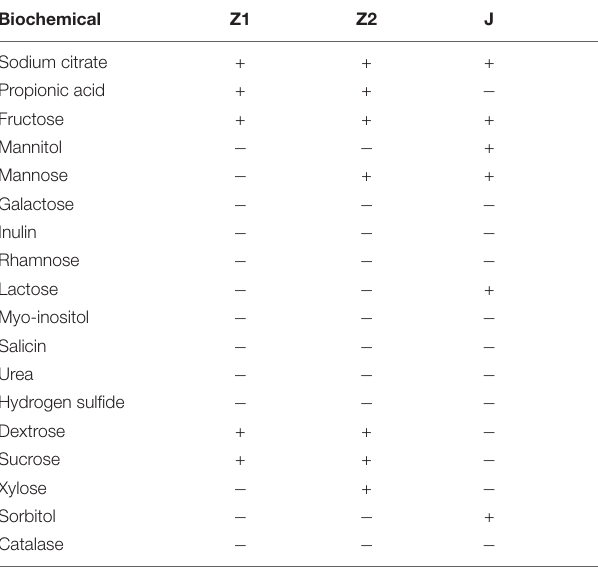
TABLE 2 | Biochemical characterization of bacterial